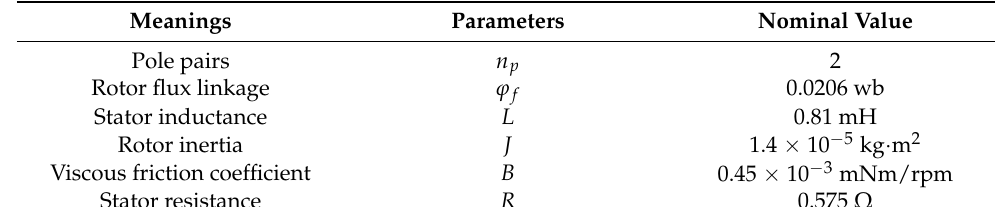
Table 2. Parameters of PMSM system in simulations when the ambient temperature is 150 ◦ C.